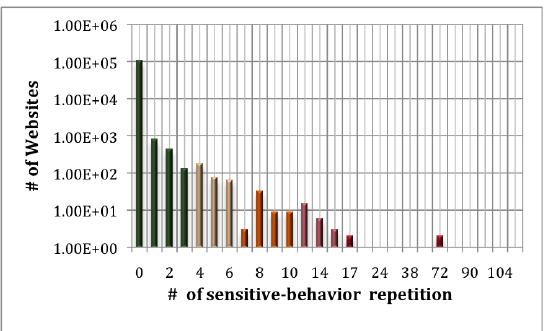
Figure 12. Amount of websites that match the web cache-based timing probing attack pattern for a certain time.